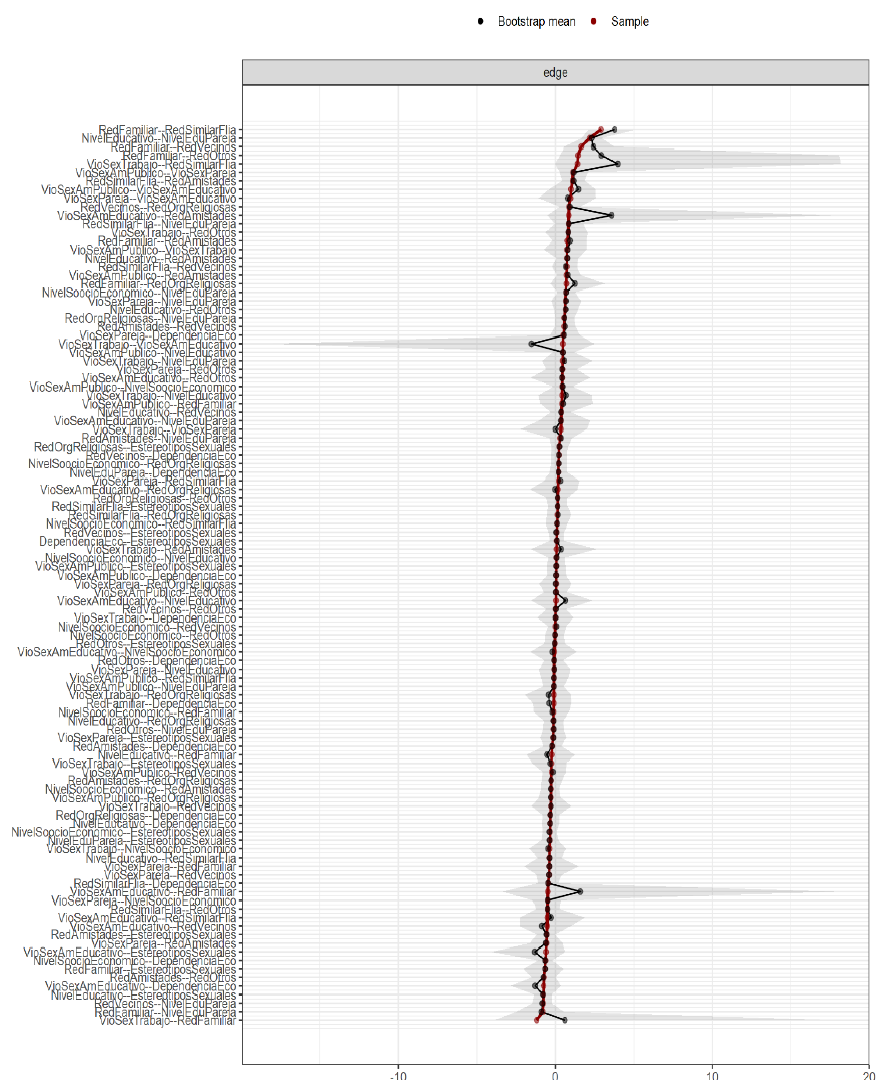
Figure 2. Neural network goodness-of-fit indicator.